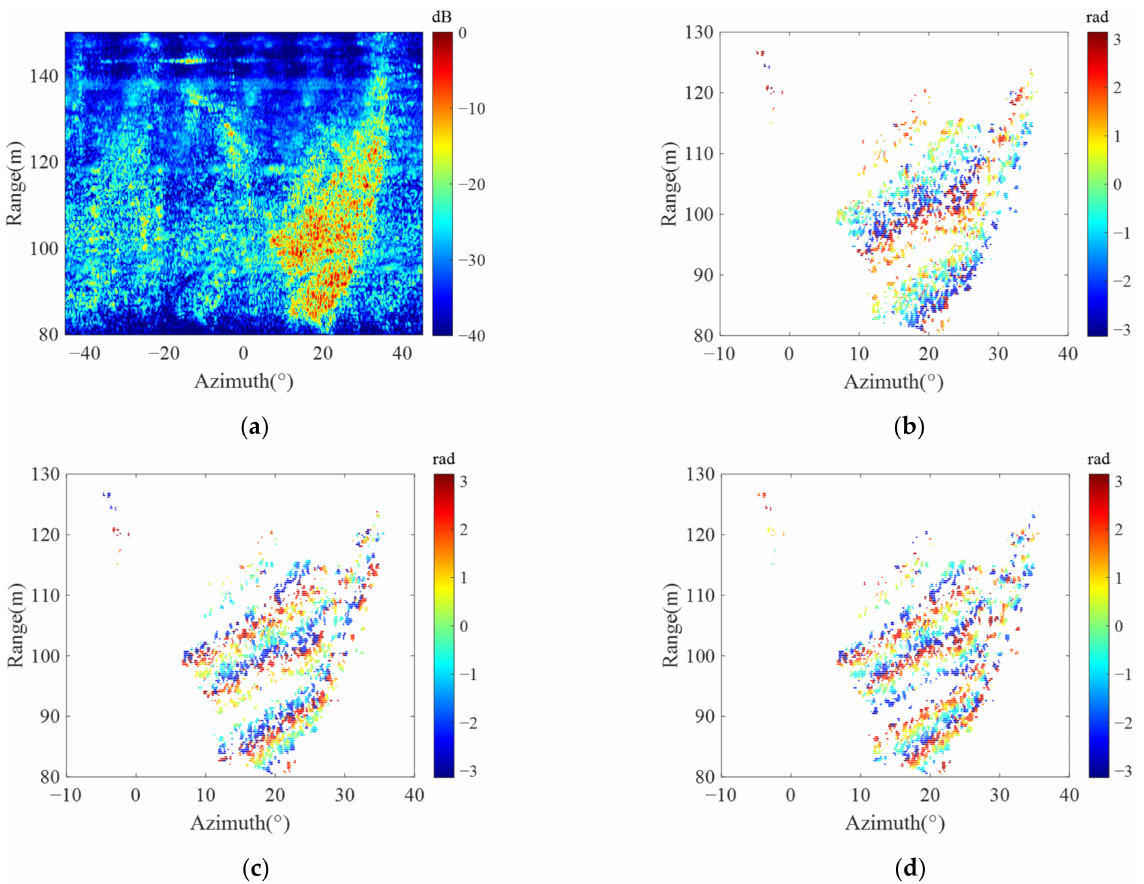
Figure 10. SAR images and interferograms of different baselines. ( a ) SAR main image, ( b ) 7 cm baseline, ( c ) 13 cm baseline, and ( d ) 17 cm baseline.